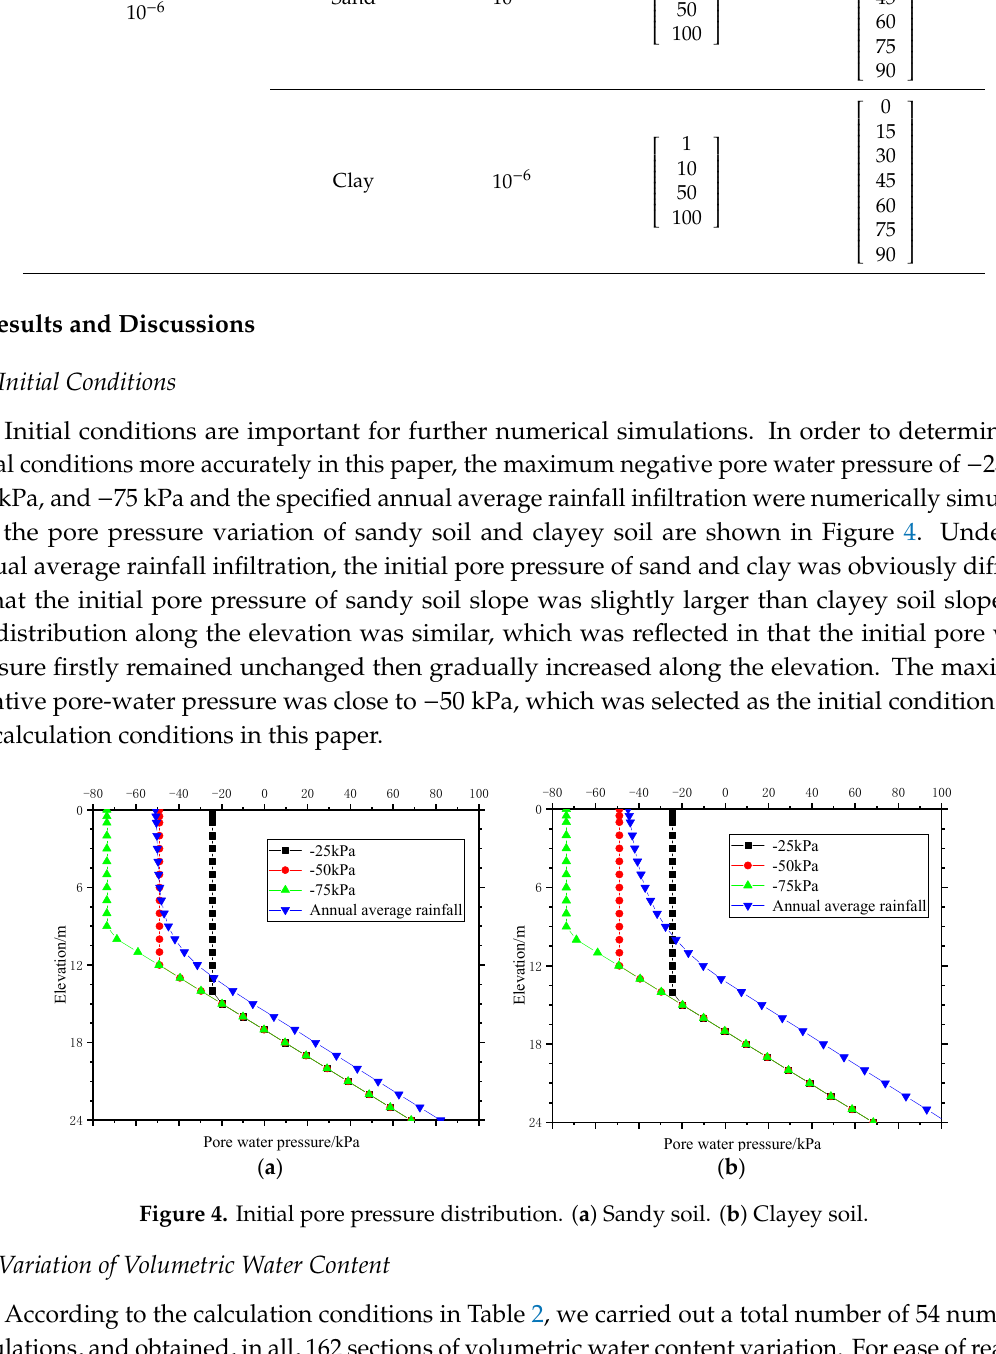
( f ) Figure 5. Variation of volumetric water content under different α values for sandy soil. ( a ) Top of the slope with k r = 10. ( b ) Middle of the slope with k r = 10. ( c ) Toe of the slope with k r = 10. ( d ) Top of the slope with k r = 100. ( e ) Middle of the slope with k r = 100. ( f ) Toe of the slope with k r = 100.